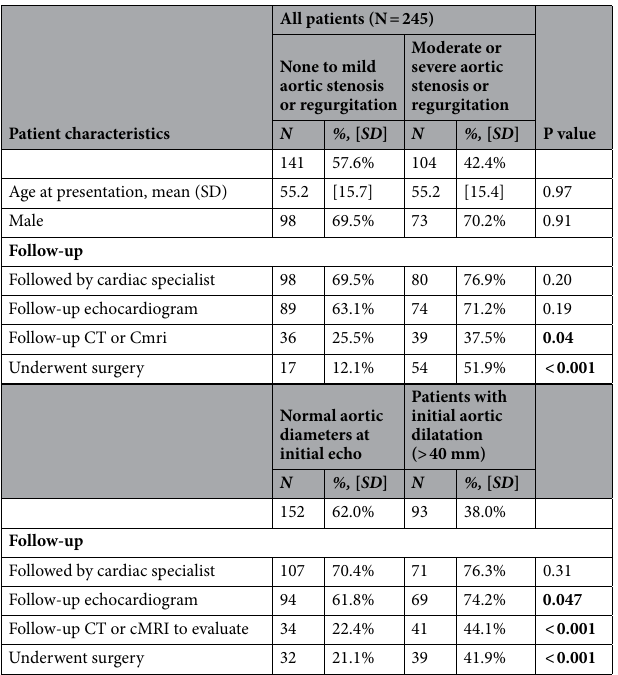
Table 2. Follow-up patterns of patients based on initial valve or aortic dysfunction. BAV =bicuspid aortic valve, CT =computerized tomography, echo =echocardiogram, c MRI =cardiac magnetic resonance imaging, Stdev or SD =standard deviation, yrs =years. Significant values are in